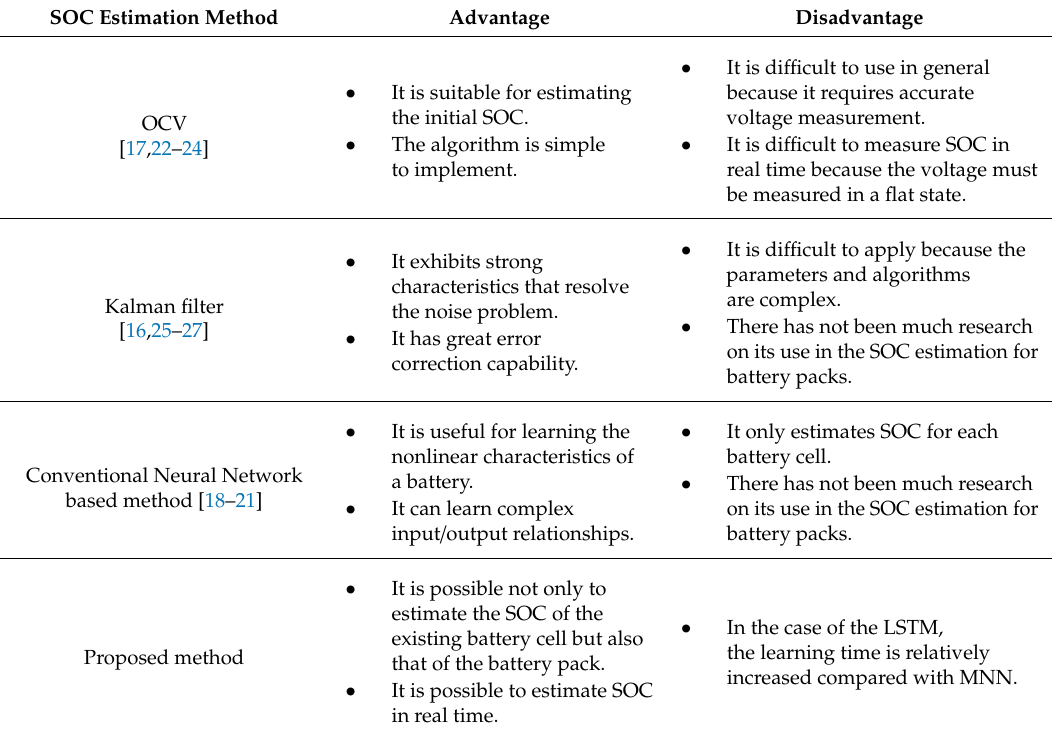
Table 1. Advantages and disadvantages of the open-circuit voltage (OCV), Kalman filter, neural network methods and the proposed